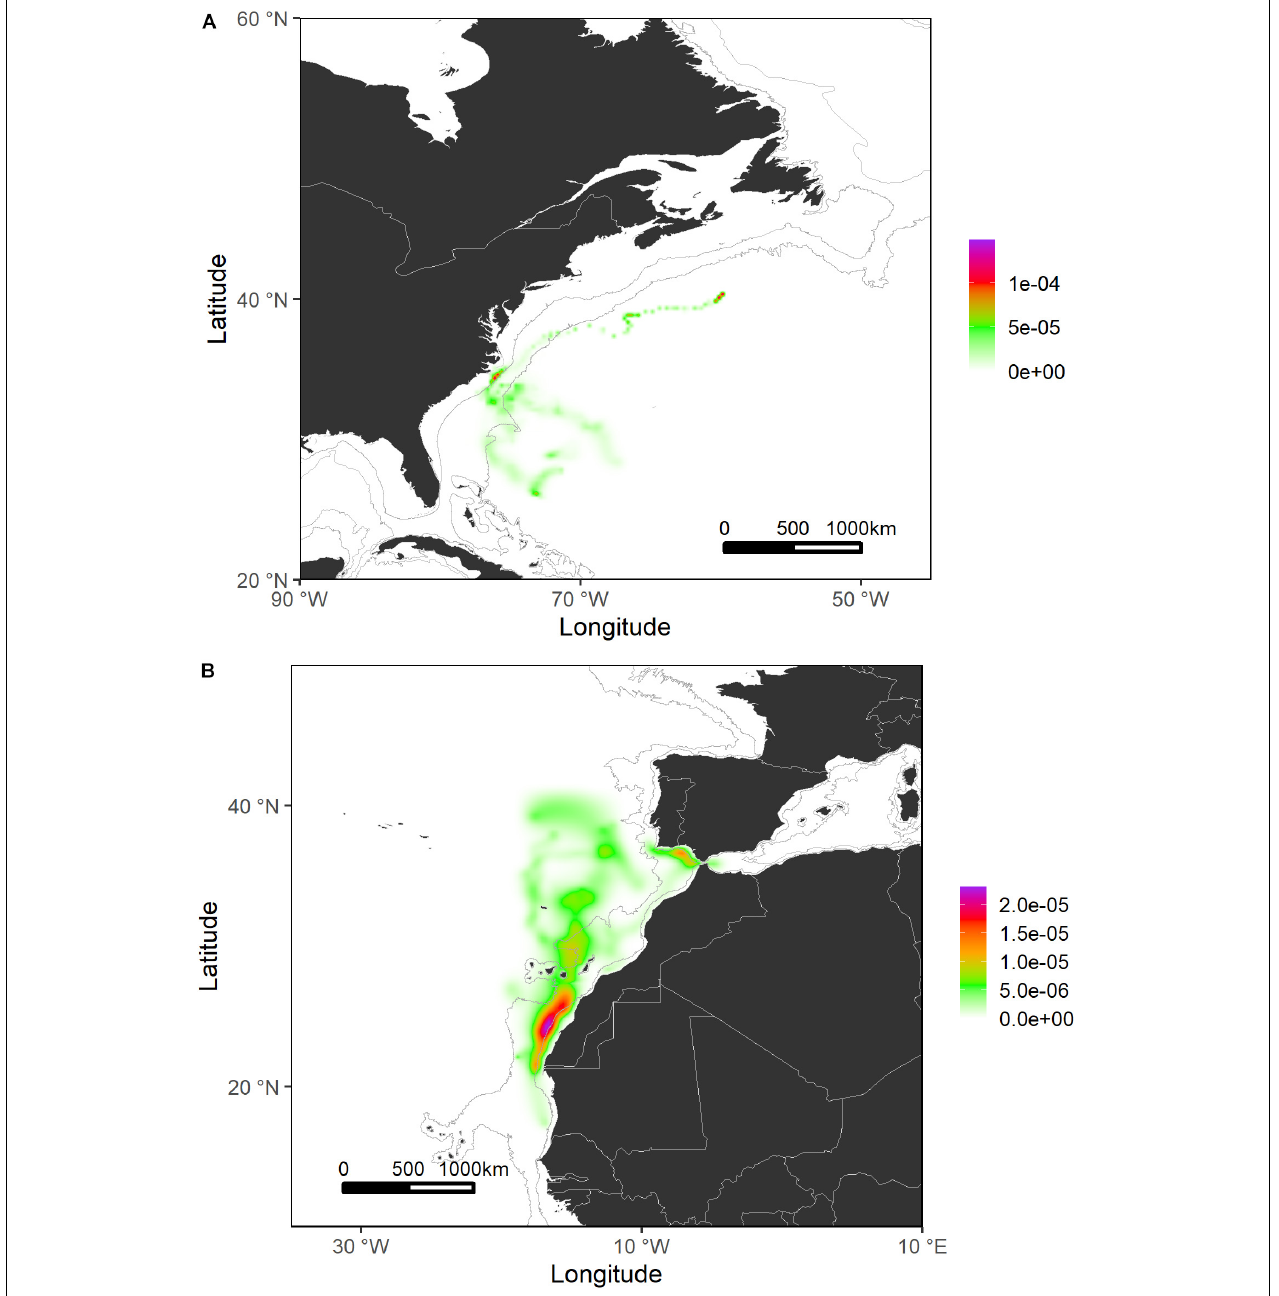
FIGURE 4 | Probability surfaces of the spatial distribution of shortfin makos tagged in the Northwest Atlantic (A) and Northeast Atlantic (B) regions. Gray lines represent the boundaries of continental and insular margins (140–3,500 m